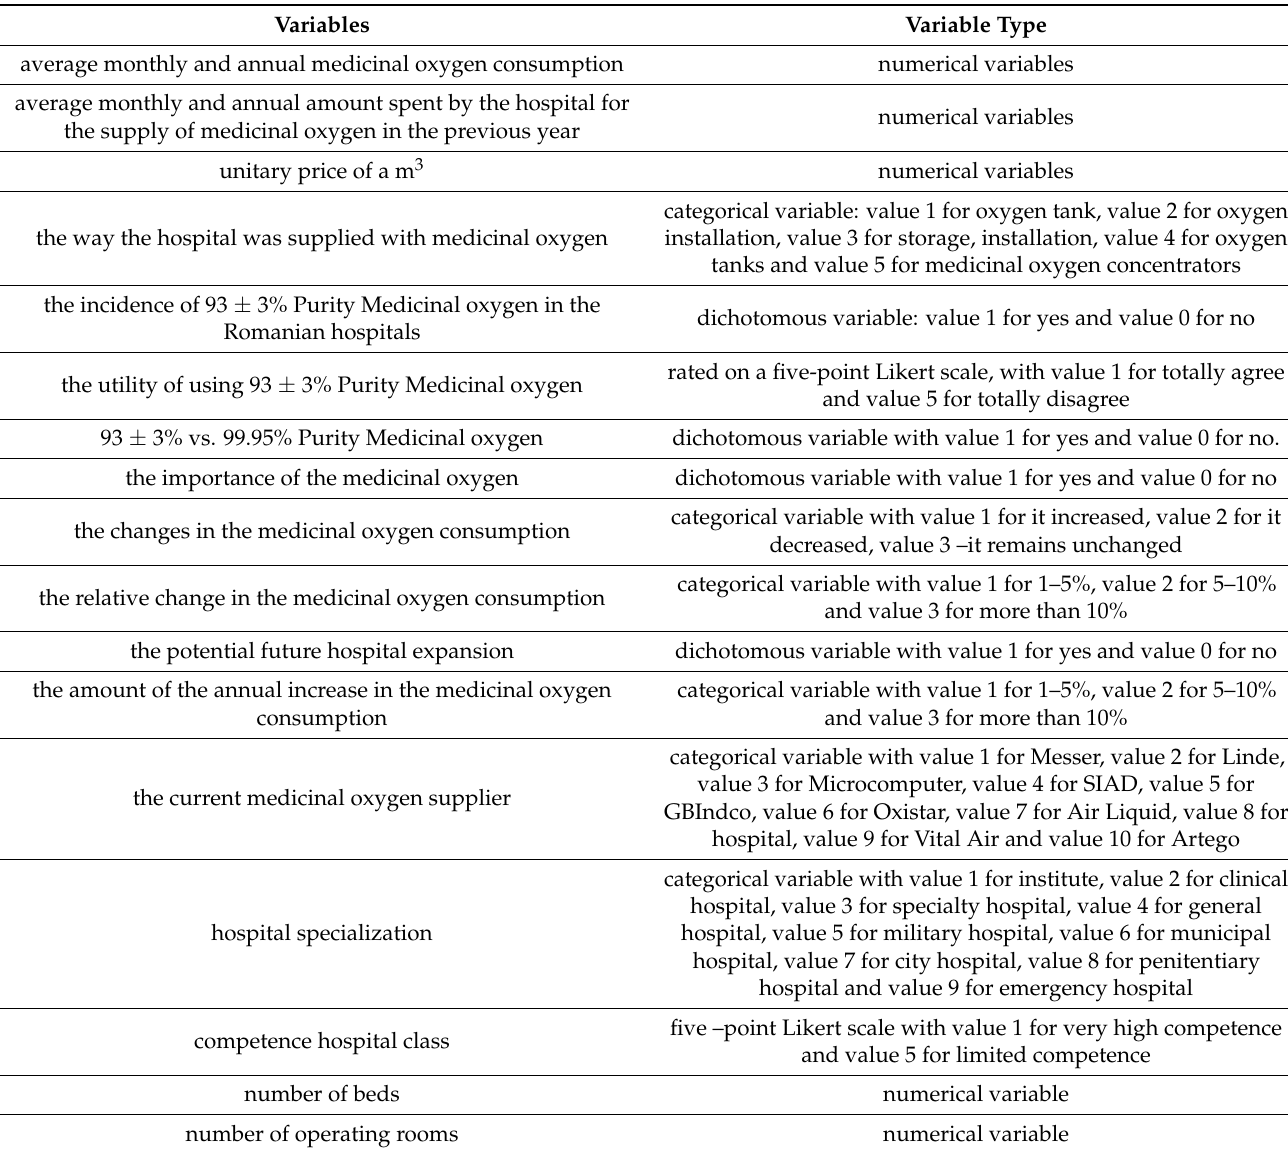
Table A1. Variables